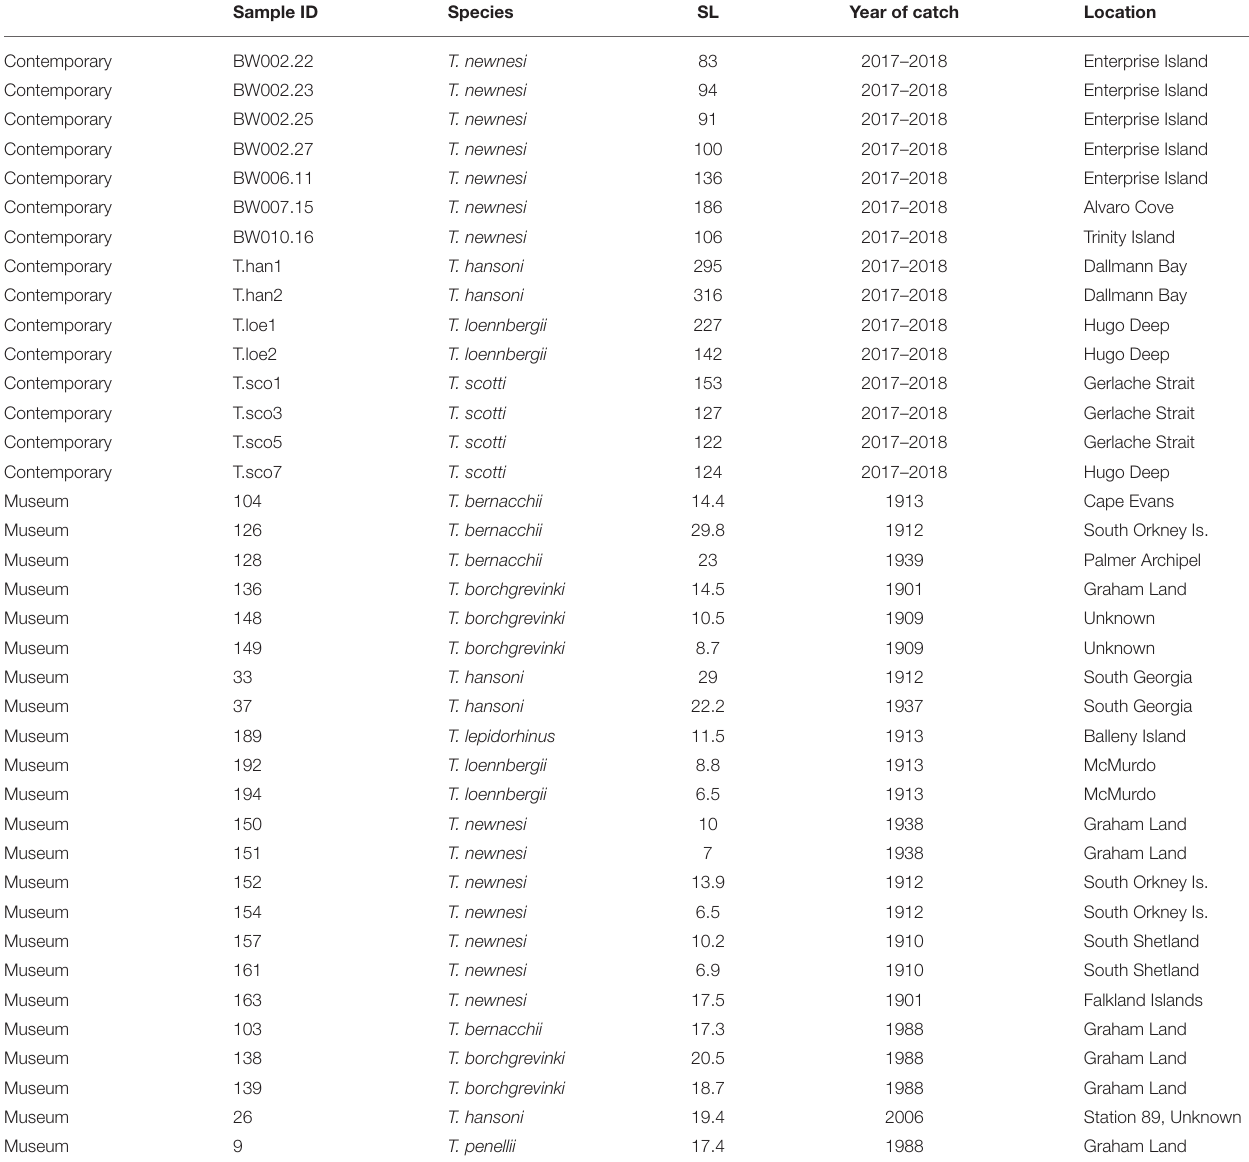
TABLE 1 | List of fish included in Figures 2 , 4 , 5